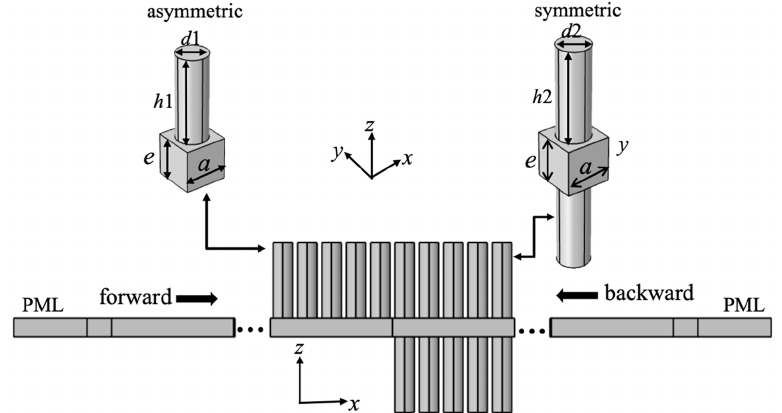
Figure 1. Schematic of the pillared meta-plate consisting of symmetric- and asymmetric-sided pillars on a thin plate arranged in a square array of lattice constant a . Each pillar has a diameter d and a height h . The plate has a thickness e . The forward and backward propagating directions are defined along the + x and − x axis, respectively.